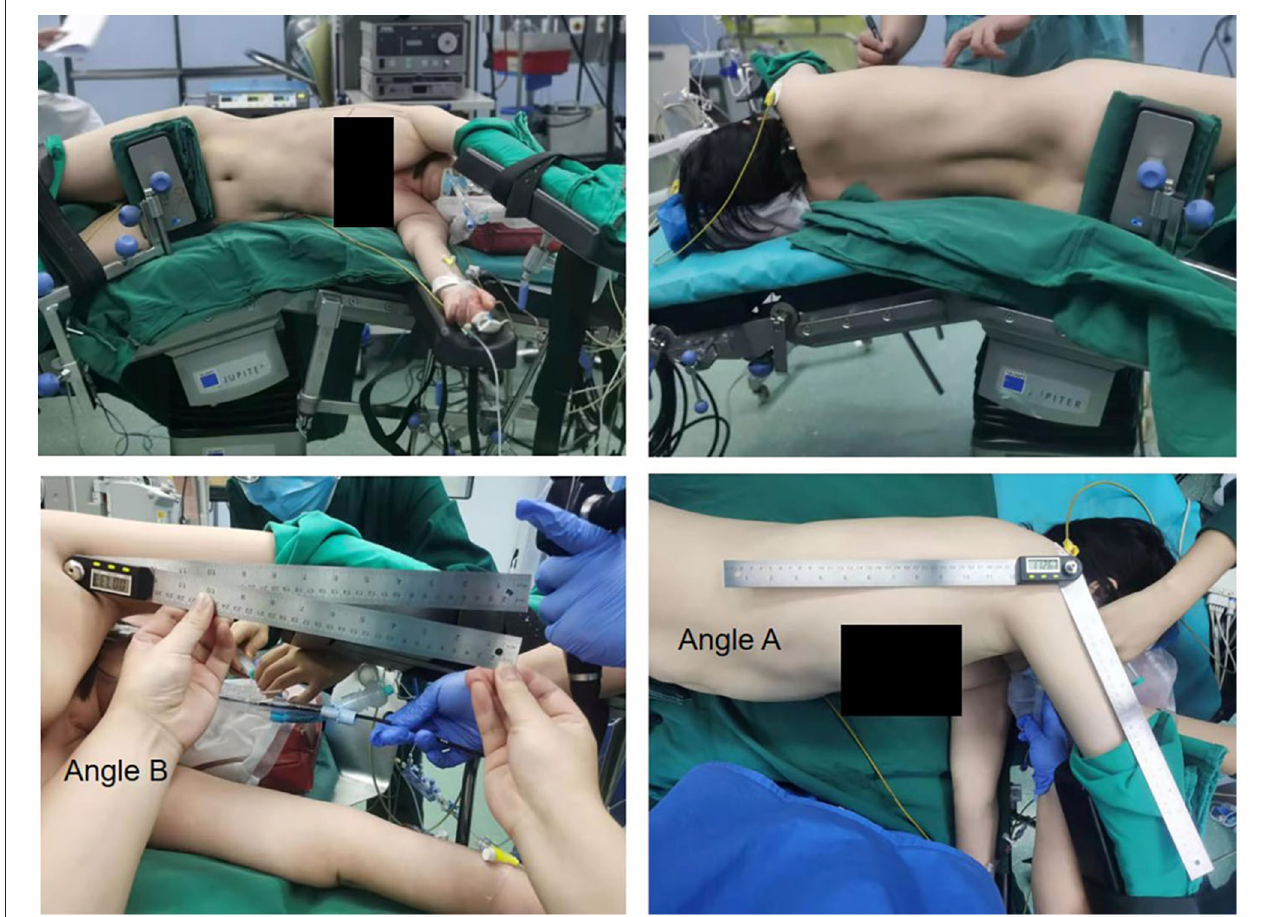
FIGURE 1 | The representative position of patients during the surgery and measurement mode of angle A and B.